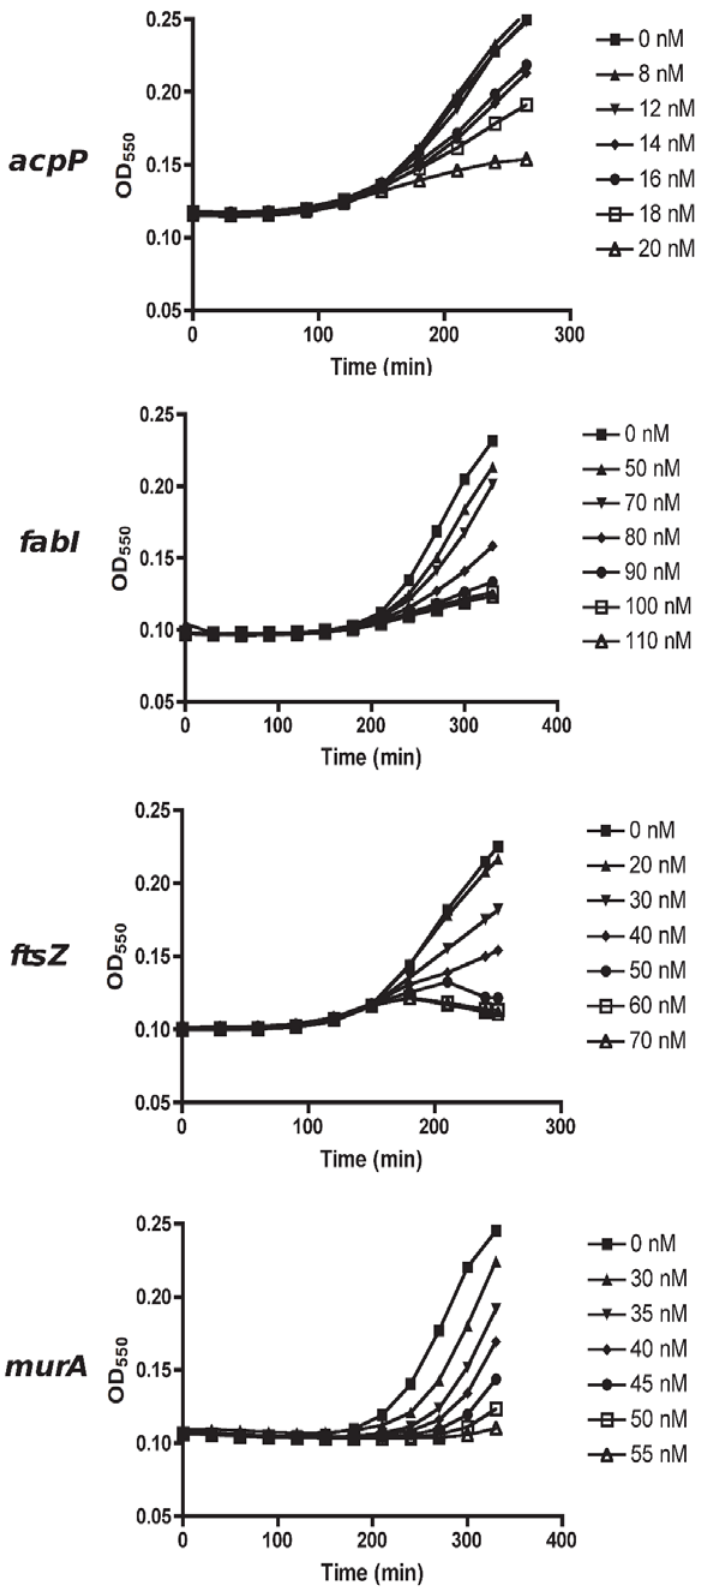
Figure 2. Dose dependent growth inhibition of antisense PNA-treated AS19 cells. Overnight AS19 cultures were sub-cultured in fresh media containing different PNA doses for each gene, and its growth monitored by turbidity. Six doses were chosen for each PNA, so as to obtain a titration in growth inhibition. Growth profiles terminated when all cultures were harvested at D OD 550 , 0.1 of the untreated culture, for transcript analyses.